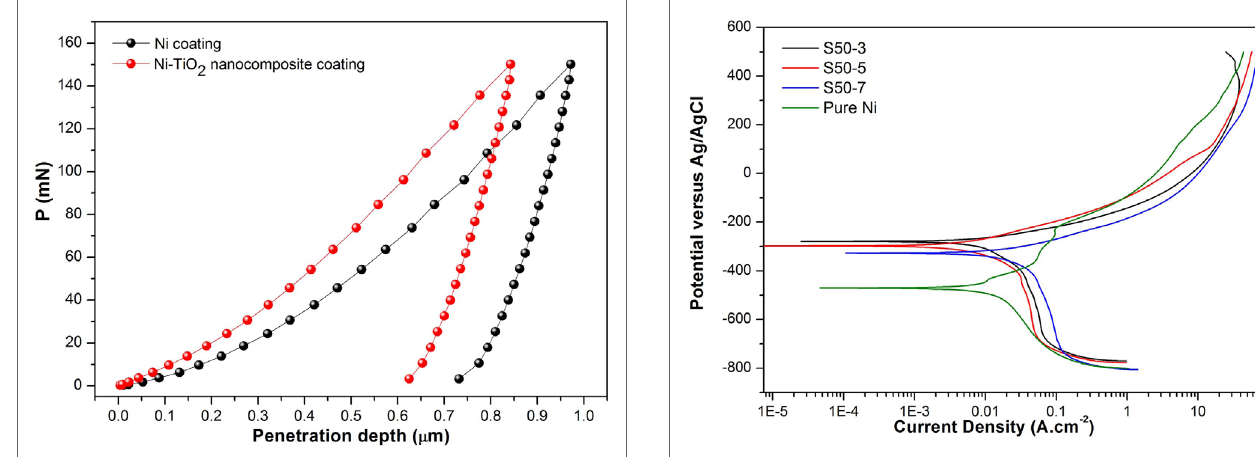
FigUre 6 | Potentiodynamic polarization curves of pure ni and ni–TiO 2 nanocomposite coatings deposited with 50 nm sized TiO 2 nanoparticles at 1 g l − 1 concentration and 3, 5, and 7 a dm − 2 current densities . TaBle 5 | corrosion potential ( E cor ) and corrosion current density ( I cor ) values of pure ni and ni–TiO 2 nanocomposite